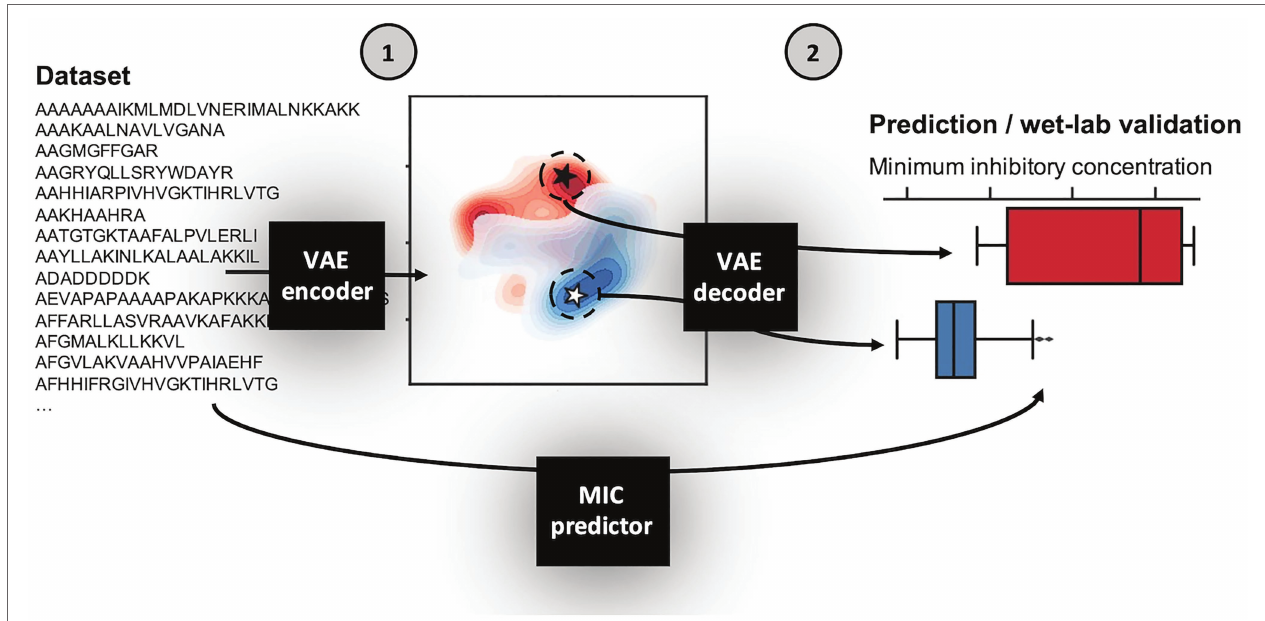
FIGURE 1 | Schematic of variational autoencoder (VAE) antimicrobial peptide (AMP) generation and design process. The VAE AMP generation and design process occurs in two stages: (1) training the VAE for the development of the latent space and a regression model for activity prediction, and (2) sampling from the latent space, generation of new AMPs, and assignment of predicted MIC values. The first step of Stage 1 was to train the VAE on the E. coli dataset. The general design of the VAE was previously described (Dean and Walper, 2020), making use of VAE described by Bowman et al. (2015), which was reported for use in generating new sentences. Here, the number of intermediate dimensions was set to 1,024 and latent dimensions was set to 50. Training was stopped after 500 epochs or when loss decreased at a sufficiently low rate. The final state of the model was saved; the encoder is used in Stage 1 and the decoder is used in Stage 2. The MIC prediction regression model is similarly trained on the same dataset and used in Stage 2 following sequence generation by the VAE decoder to assign MIC values for those new AMPs against E. coli . A more detailed description of the framework design is provided in the Methods